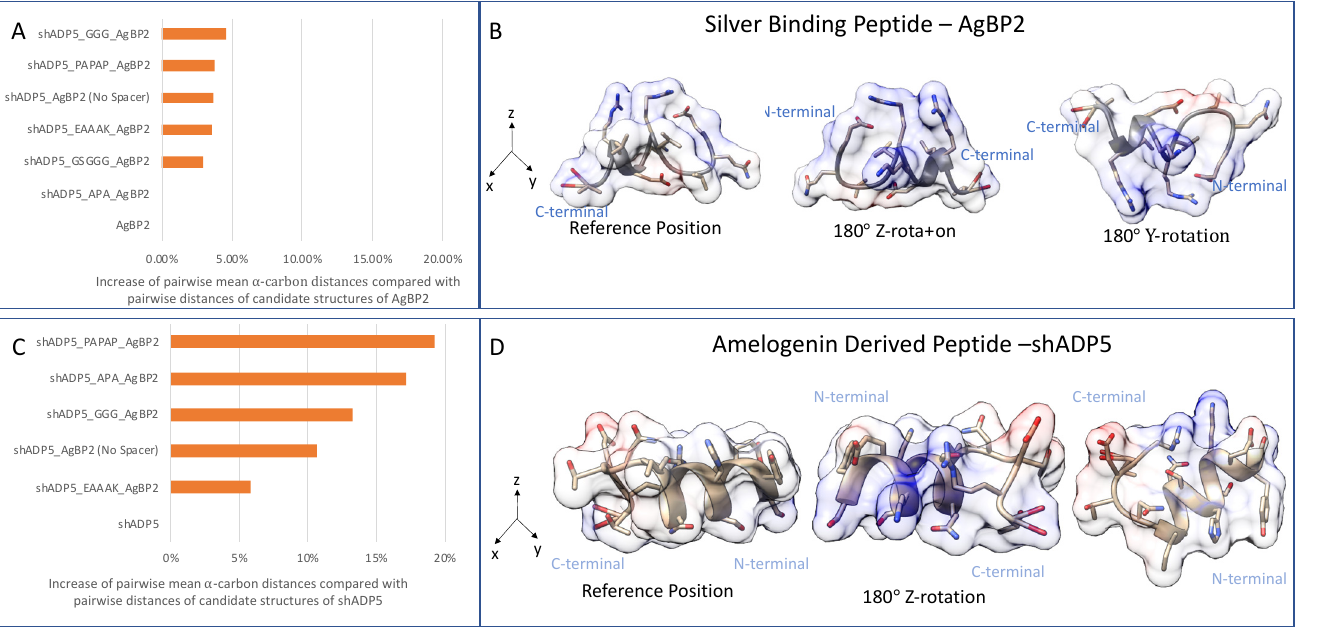
Figure 2. Structure similarity of bifunctional peptide domains compared with each domain in isolation for the silver-binding peptide and amelogenin-derived peptide. Panel ( A ), pairwise distance of domain structures compared with non-chimeric domain; Panel ( B ), single-domain structure views of AgBP2; Panel ( C ), similarity comparison for amelogenin-derived peptide (shADP5) chimeric; Panel ( D ), pairwise distance compared with non-chimeric domain single-domain structure views of shADP5. A 1% increase in pairwise distance would be the same as 101% increase in the mean pairwise α -carbon distance for the non-chimeric domain. Table 1. Distances between AgBP2 and shADP5 compared with the bifunctional peptides by the mean sum of squares across the single-domain residues. Summed backbone change (%) is the combined change including both